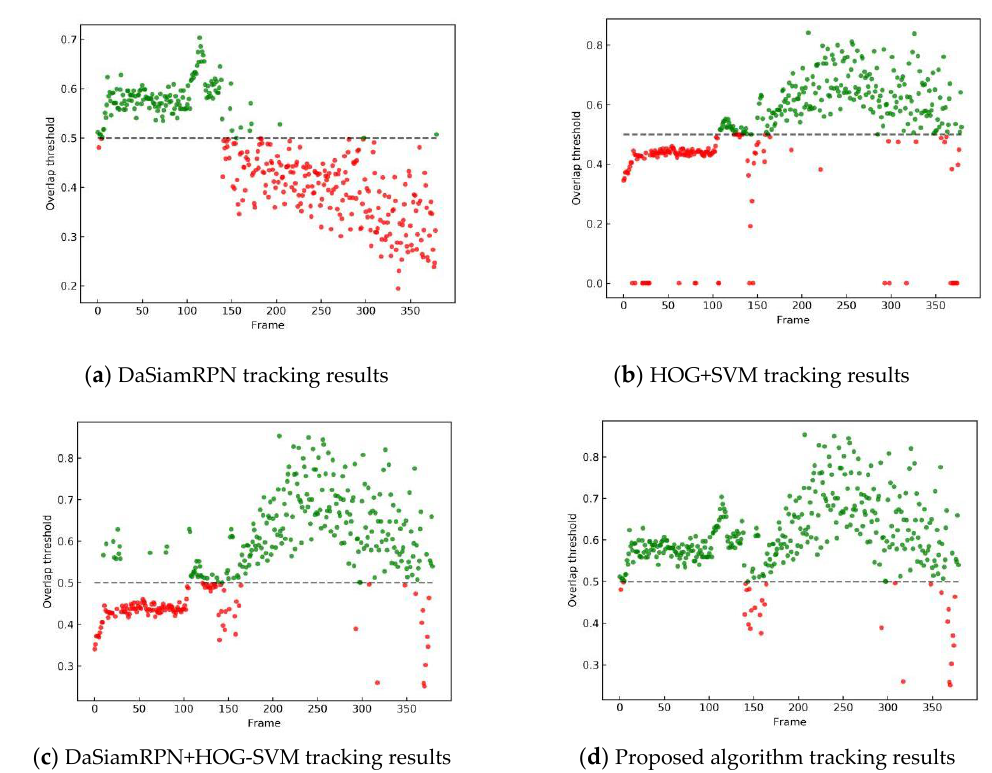
Figure 10. The overlap precision scatter diagram of Video Sequence II with four different trackers.